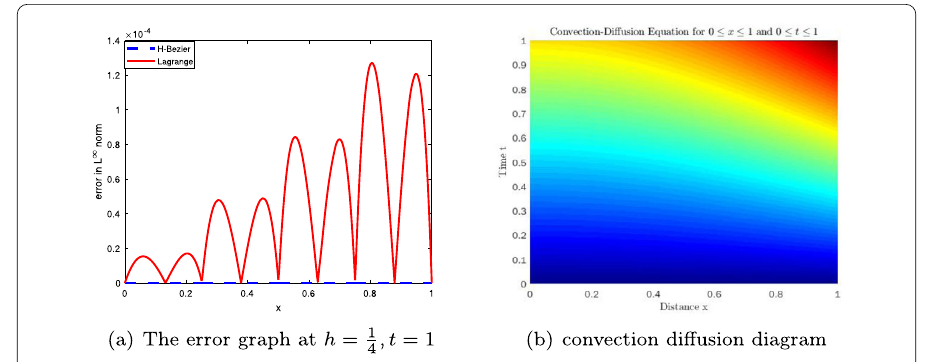
Figure 7 The error graph and convection diffusion diagram